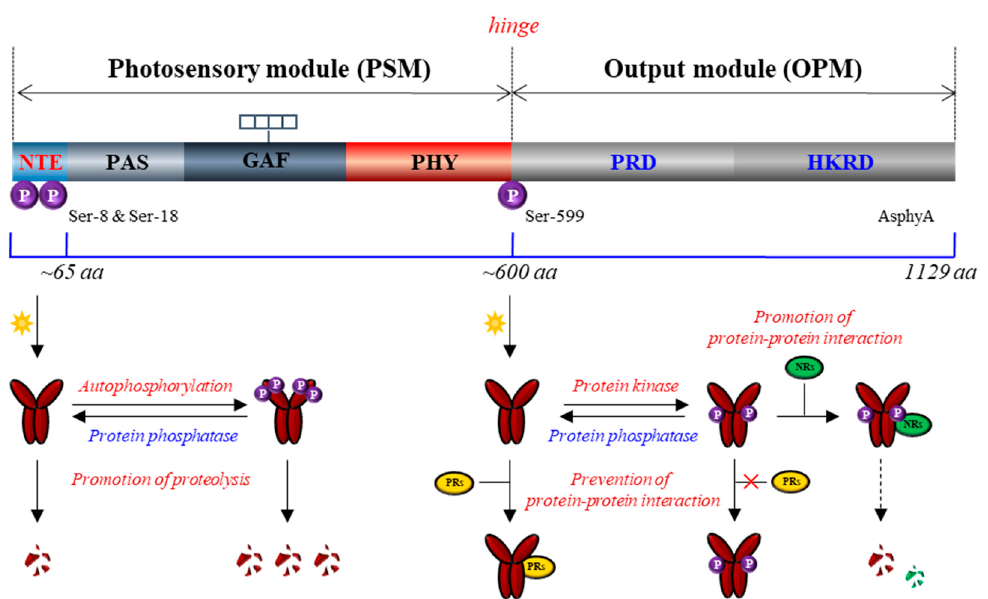
Figure 3. The proposed molecular mechanisms for the regulation of phyA as phosphoproteins. A simplified domain structure of Avena sativa phytochrome A (AsphyA; 1,129 aa) is shown. The N-terminal photosensory module (PSM) consists of N-terminal extension (NTE, 1~65 aa) and the photosensory core composed of Per/Arnt/Sim (PAS), cGMP phosphodiesterase/adenylyl cyclase/FhlA (GAF), and phytochrome-specific (PHY) domains. The tetrapyrrole chromophore is covalently attached to a cysteine residue in the GAF domain. The C-terminal output module (OPM) contains a PAS-repeat domain (PRD) and a histidine kinase-related domain (HKRD). The PSM and OPM are linked by a hinge region. There are three phosphorylation sites that have been determined in AsphyA, in which Ser-8 and Ser-18 in the NTE are autophosphorylated and Ser-599 in the hinge region might be phosphorylated by unknown protein kinase(s). The autophosphorylation of AsphyA has been suggested as a mechanism of signal desensitization for terminating phyA function after photoactivation via the promotion of its proteolysis. The phosphorylation at Ser-599 regulates protein-protein interactions with downstream signaling partners, in which the hinge region phosphorylation can prevent its interaction with positive regulators (PRs) such as NDPK2. Based on the results of Arabidopsis phyA phosphorylation site mutants in the hinge region, it is also possible that the hinge region phosphorylation promotes the interaction with negative regulators (NRs) such as PIF3, resulting in the promoted proteolysis of NRs with phosphorylated phyA. This phosphorylation can be reversed by protein phosphatases such as PAPP5. Thus, the phosphorylation in the hinge region can play roles in phyA signaling either negatively (via the prevention of the interaction with PRs) or positively (via the promotion of the interaction with NRs and subsequent proteolysis). The functional roles of the hinge region phosphorylation need to be elucidated more clearly in the future. Based on the observation that Ser-599 in the hinge region of AsphyA is phosphory- lated in vitro and in vivo in a Pfr-specific manner [103], the functional role of Ser-599 phosphorylation was first investigated using transgenic plants with S599A mutant. The